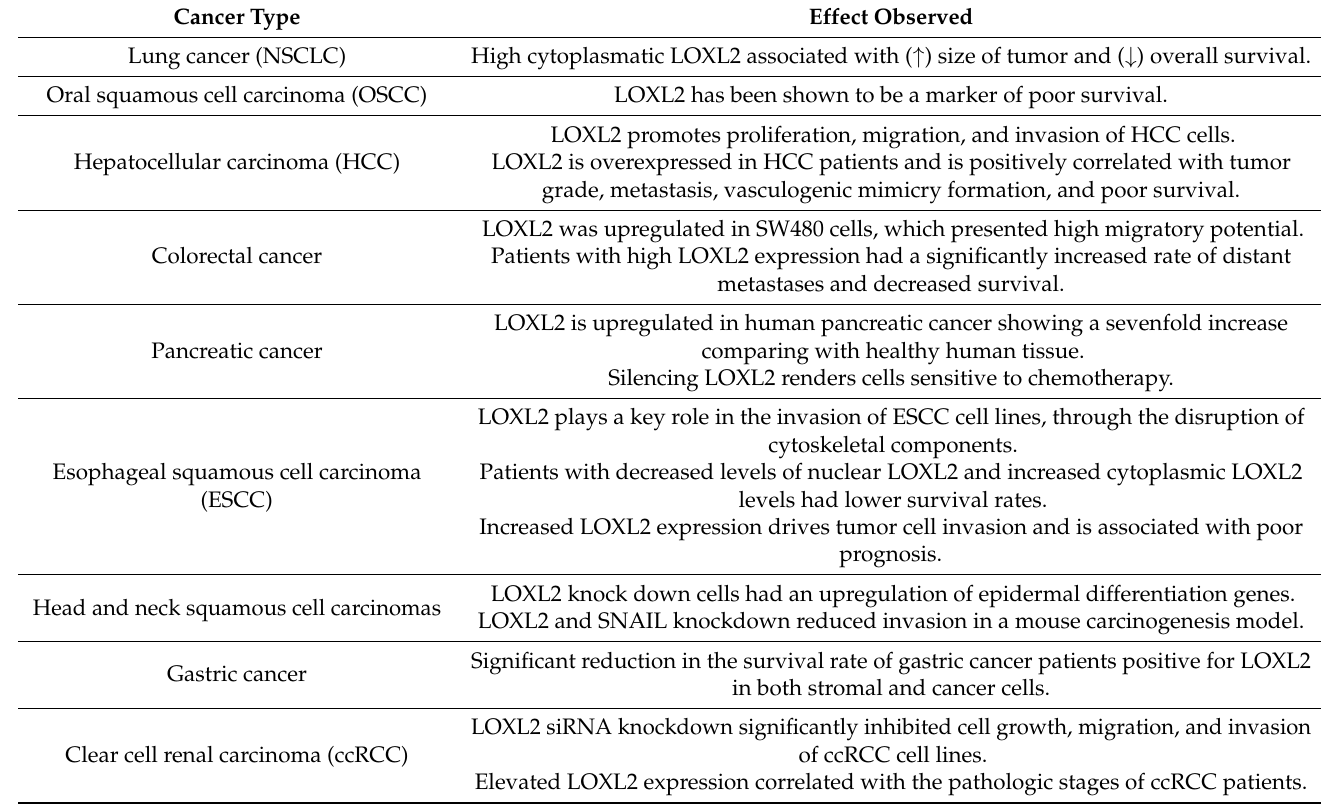
Table 1. The impact of LOXL2 in different types of